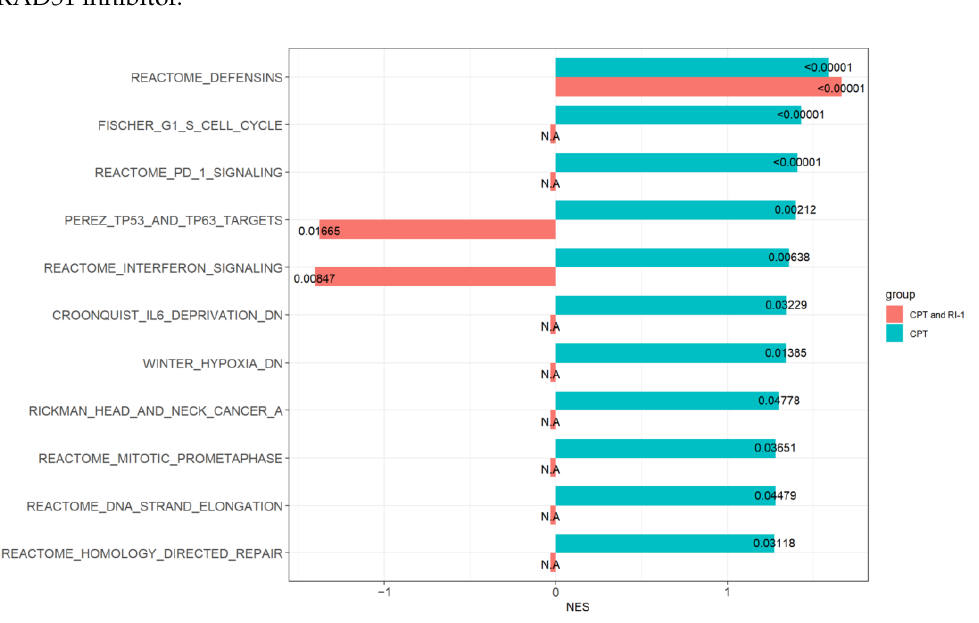
Table 1. Elevated RAD51 expression is commensurate with immune dysregulation. RAD51 expres- sion was evaluated for correlation with various immune components involved in inflammation and cellular immunity in Esophageal adenocarcinoma (dataset; GSE13898). Elevated RAD51 expression correlated with increased expression of various immune components.